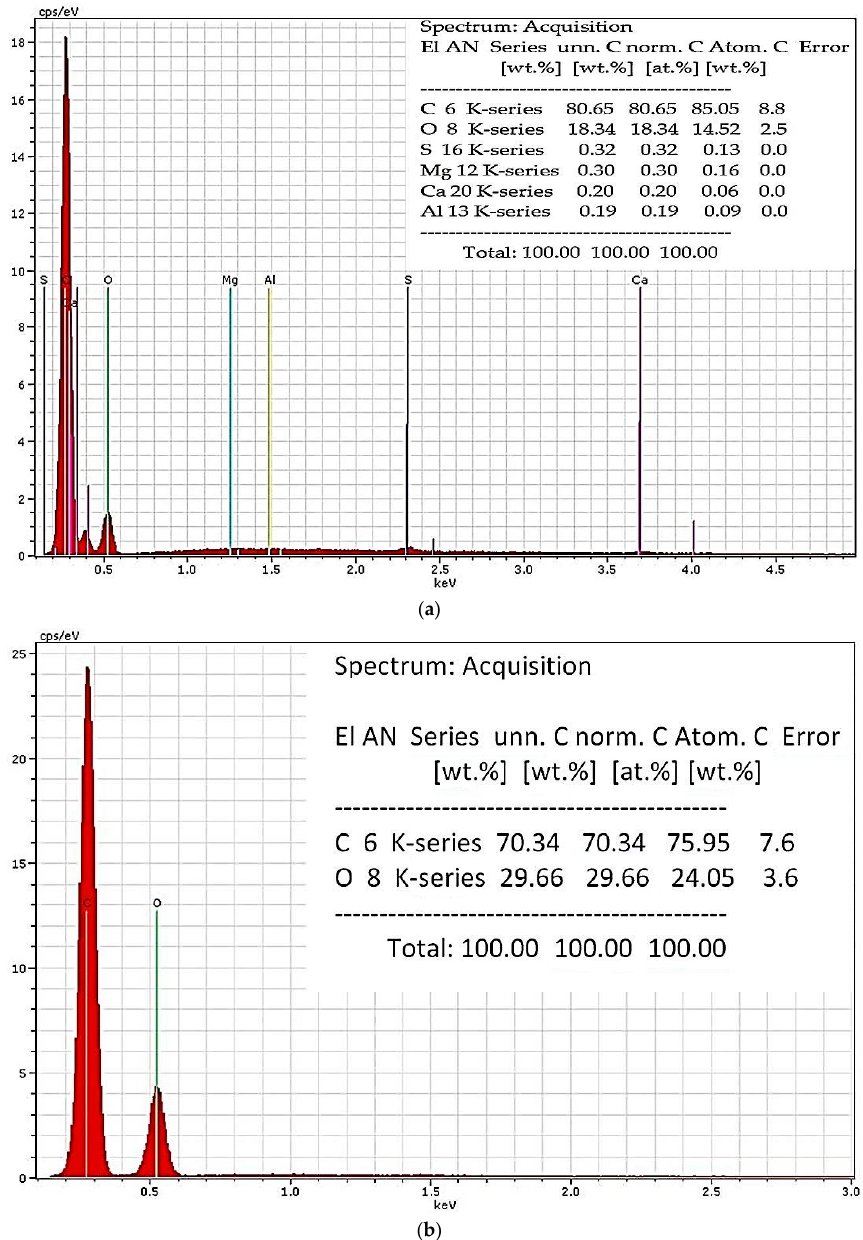
Figure 5. SEM-EDX analysis: ( a ) Sample 1 ; ( b ) Sample 2